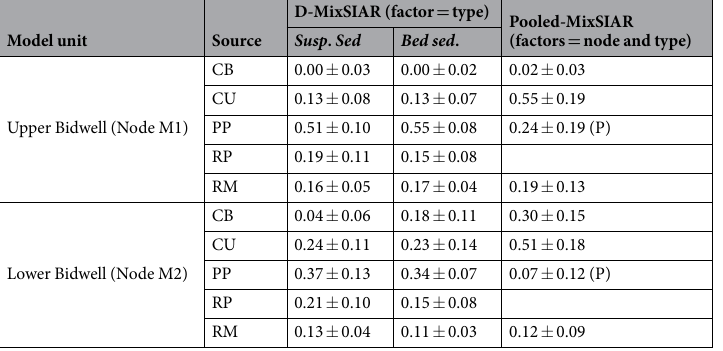
Table 3. D-MixSIAR and pooled MixSIAR source apportionment data for the Bidwell watershed for model runs with an informative prior regarding limited channel bank